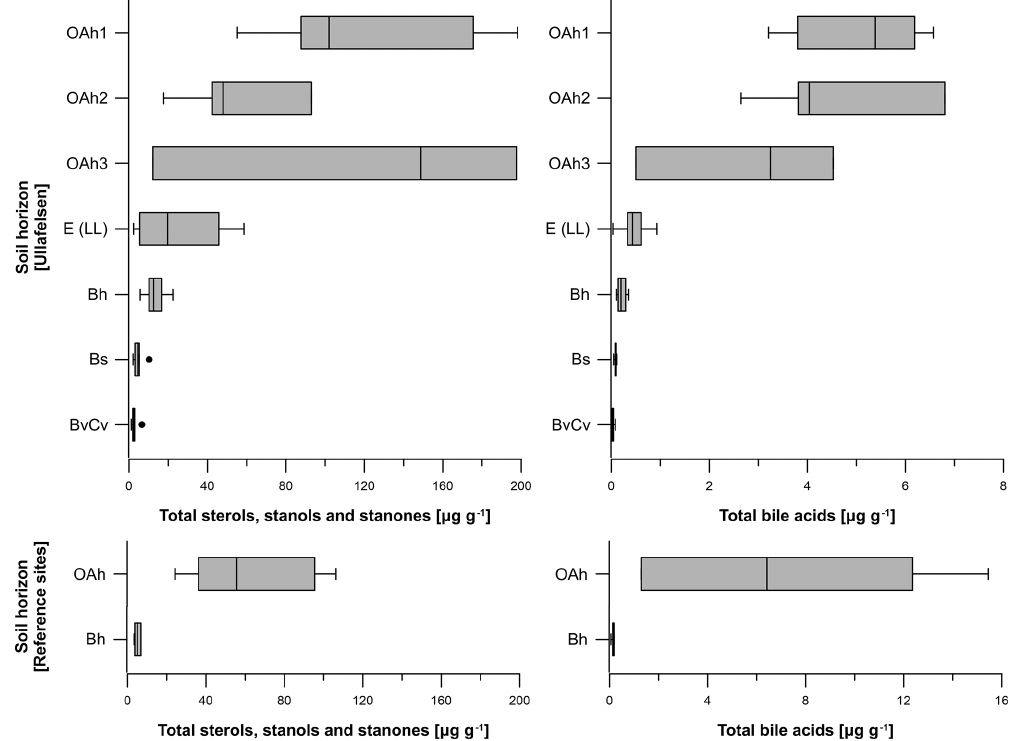
Figure 5. Boxplots illustrating the total steroid (sterols, stanols, stanones and bile acids) contents (in micrograms per gram of dry matter) of the investigated soil profiles from the prehistorical encampment site of Ullafelsen and reference sites in the Fotsch Valley, Stubai Alps, Austria, categorized by the soil horizons OAh1 ( n = 6), OAh2 ( n = 4), OAh3 ( n = 3), E (LL) ( n = 8), Bh ( n = 6), Bs ( n = 5) and BvCv ( n =